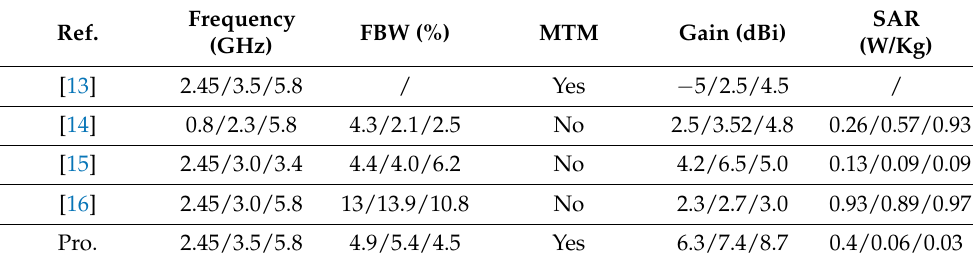
Table 3. Comparison with other triple-band wearable antennas. Frequency FBW (%) Ref. (GHz)